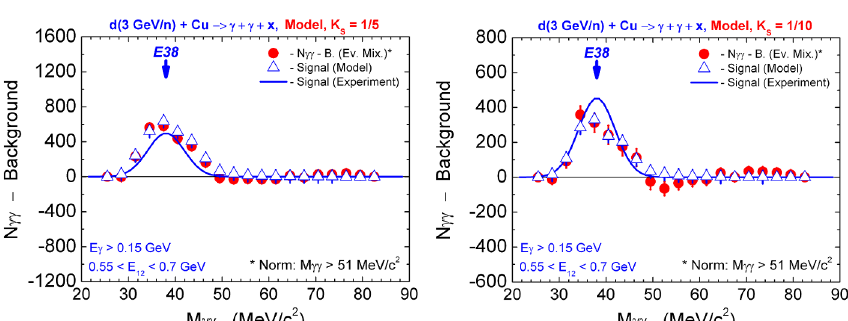
Figure 5. The ratio of the number of triggered γγ pairs under real experimental conditions (at E γ > 50 MeV (criterion (A))) on the total number in the simulated source, depending on the e ff ective mass (per 2 MeV / c 2 ) of γγ pairs for the Model after excluding the events with γγ pairs from the E(38) boson